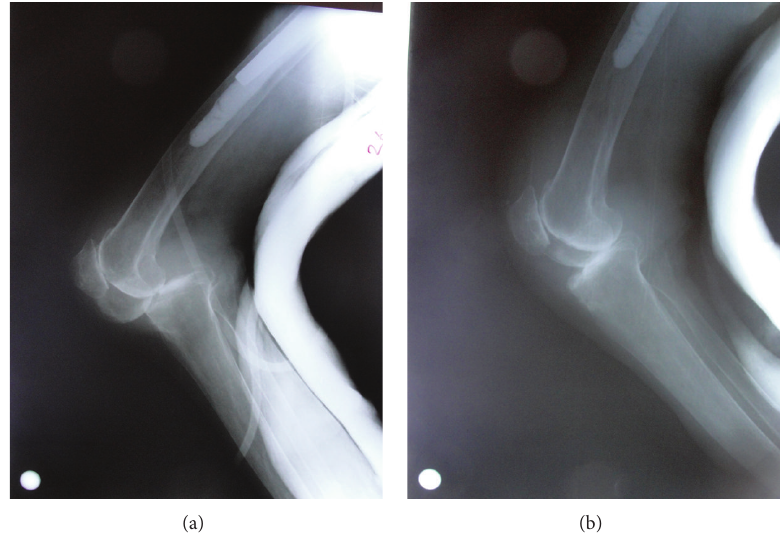
Figure 4: Posterior knee dislocation seen on radiography before and after reduction with underlying knee osteoarthritis.